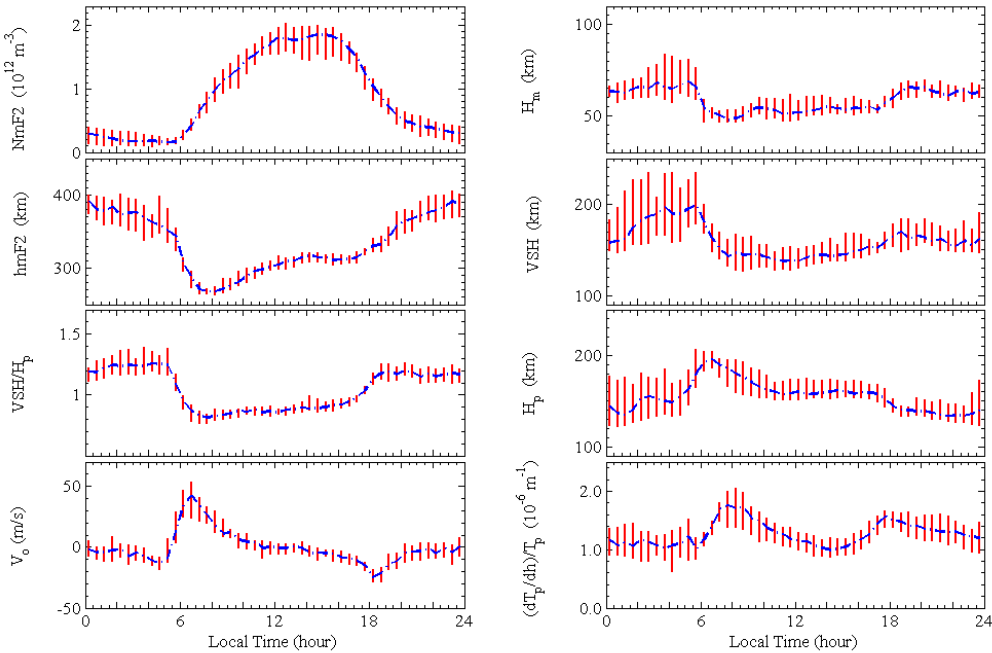
Fig. 3. The diurnal variation of N m F 2 , h m F 2 , the line-of-sight velocity V o (around 500km), the Chapman scale height H m , the vertical scale height VSH, plasma scale height H p , and the relative gradient of plasma temperatures (d T p /dh)/ T p derived from the ISR experiment at Millstone Hill. The ratio of VSH to H p is also plotted. Lines with bars represent, respectively, the half-hourly median values and the corresponding upper (UQ) and lower (LQ) quartiles during the ISR